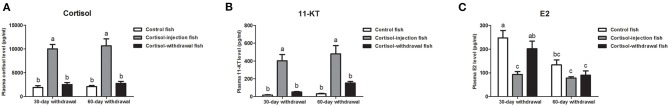
Serum steroid hormone levels after cortisol withdrawal. Changes in serum (A) cortisol levels, (B) 11-KT levels, and (C) E2 levels in the control fish, cortisol-injection fish, and cortisol-withdrawal fish at 30 days after cortisol withdrawal. Data from four fish samples are expressed as the mean ± SEM. Different letters above the bars indicate statistically significant differences (P < 0.05).